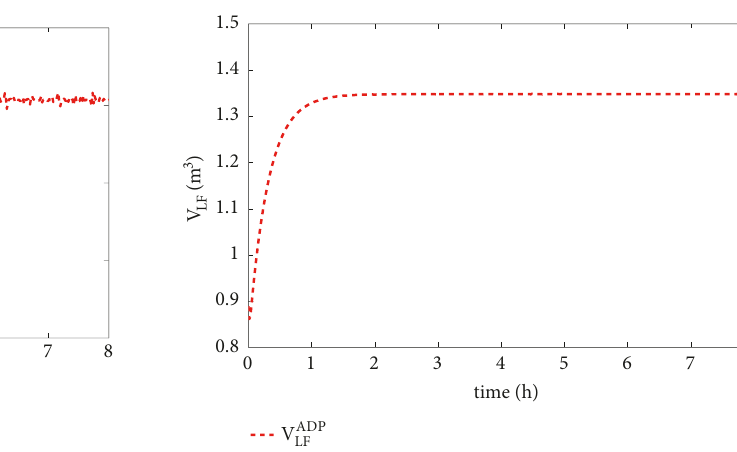
Figure 6: 𝐶 𝑃2 trajectory in Task 1.